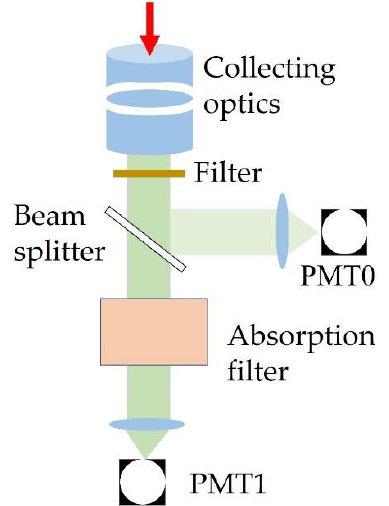
Figure 6. Schematic of the system used for Brillouin energy measurement.